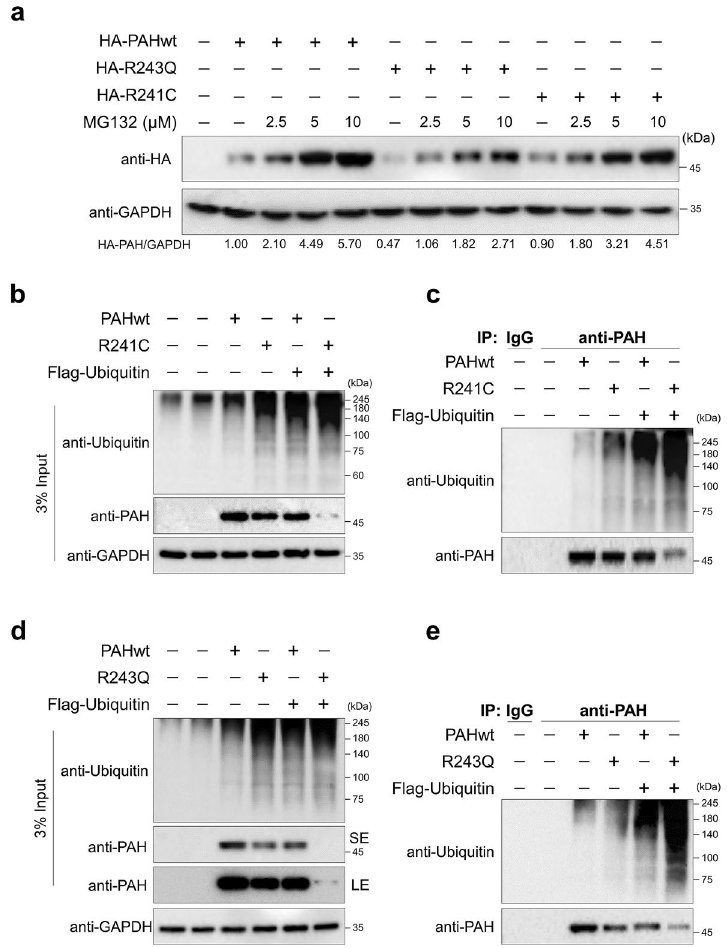
Figure 2. PAH variants are targets of proteasomal degradation. ( a ) The levels of R241C and R243Q proteins in HEK293 cells were determined by Western blotting after treatment with MG132 (2.5, 5, and 10 μM) for 12 h. Protein band intensities were estimated using the ImageJ software with reference to the GAPDH control. The band intensity for HA-PAH/GAPDH was represented below the blots. ( b-e ) HEK293 cells stably expressing PAHwt, R241C, or R243Q were transfected with Flag-ubiquitin to evaluate their ubiquitination status. Cells treated with IgG and cells transfected with empty vector were used as the negative controls. ( b , d ) represent the total cell extract used in the immunoprecipitation (input); ( c , e ) represent immunoprecipitation using anti-PAH antibody and immunoblotted with anti-ubiquitin and anti-PAH (SE, short exposure; LE, long